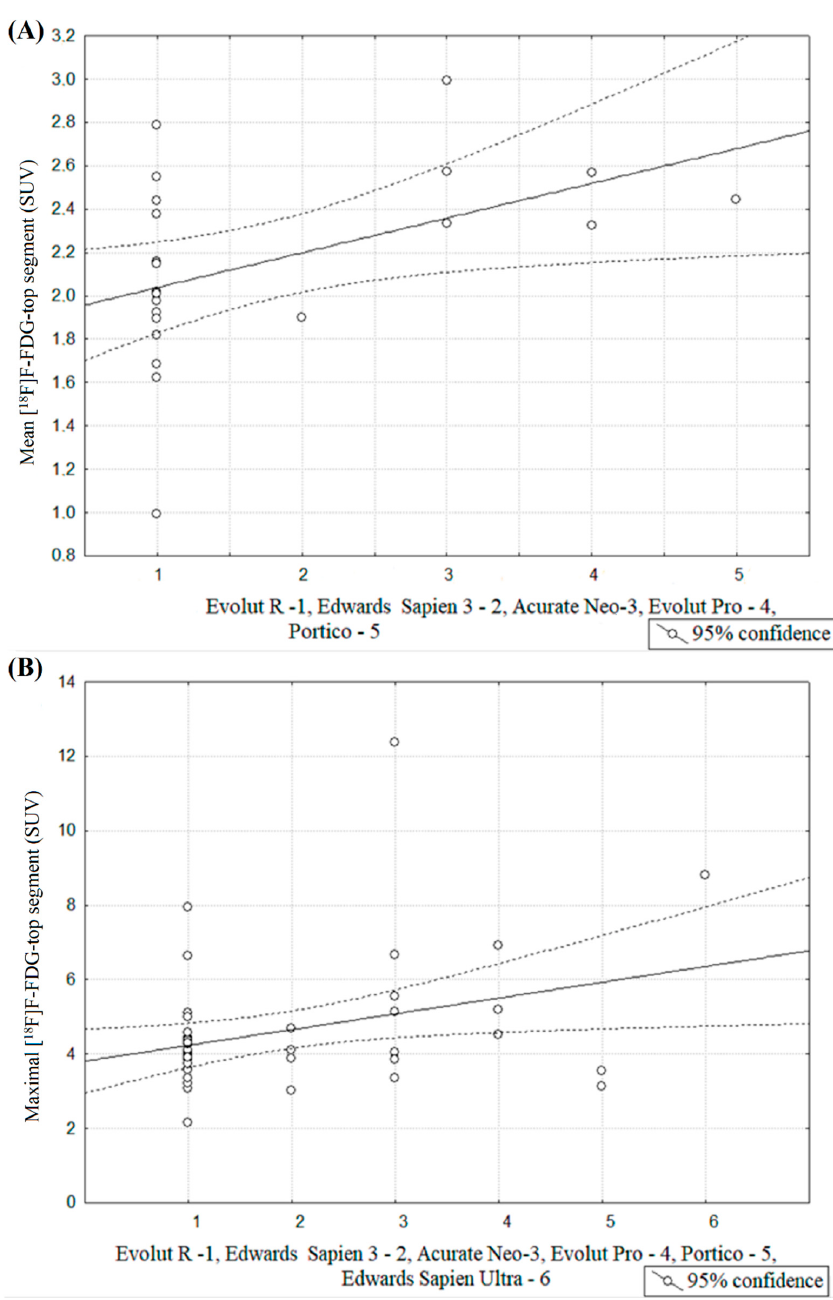
Figure 6. ( A ) Spearman’s correlation coefficient between valve type and mean [ 18 F]F-fluorodeoxyglucose top segment measured at baseline after TAVI procedure. ( B ) Spearman’s correlation coefficient between valve type and maximal [ 18 F]F-FDG top segment measured at baseline after TAVI procedure.